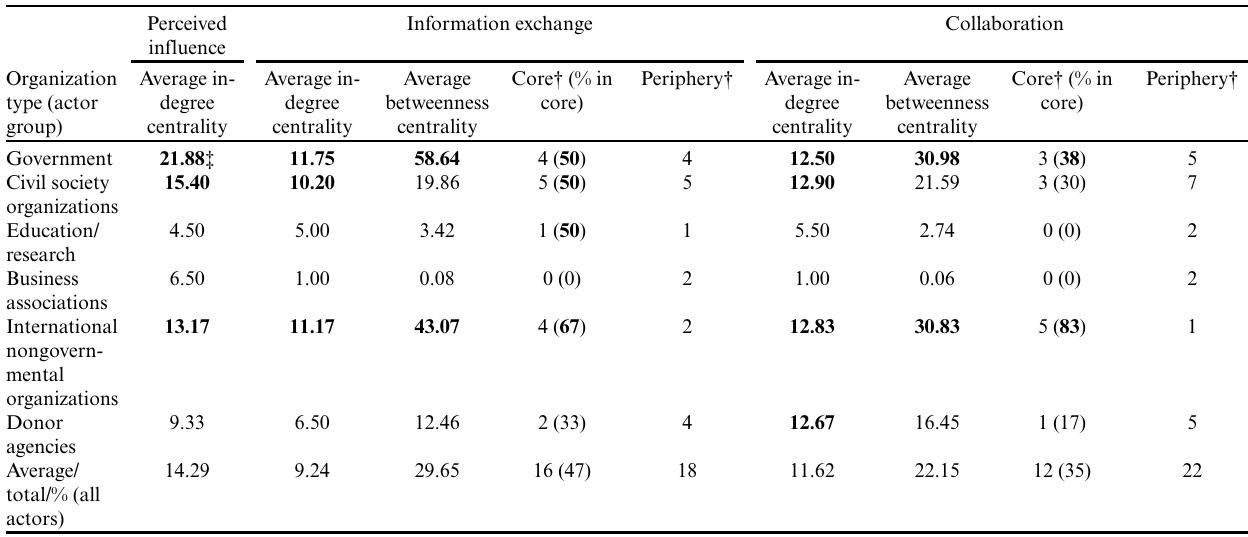
Table 4. Relative prominence of REDD+ actor groups in Nepal in perceived influence, information exchange, and